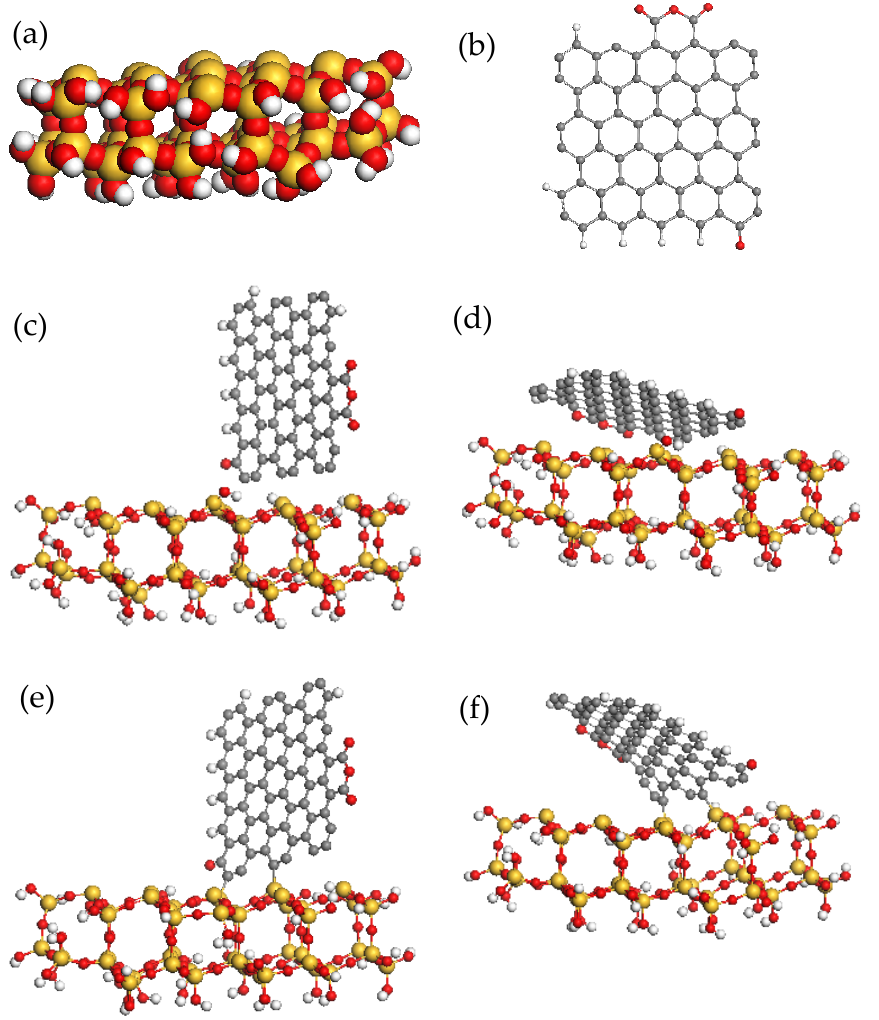
Figure 10. Equilibrium structures of (SiO 4 ) 48 ( a ) and C 66 H 6 O 4 graphene molecule ( b ) imitating α -quartz nucleus and BSU of shungite carbon, respectively. ( e , f ) Equilibrium structures of silica– shungite carbon composites at starting positions of the components ( c ) and ( d ), respectively. UHF